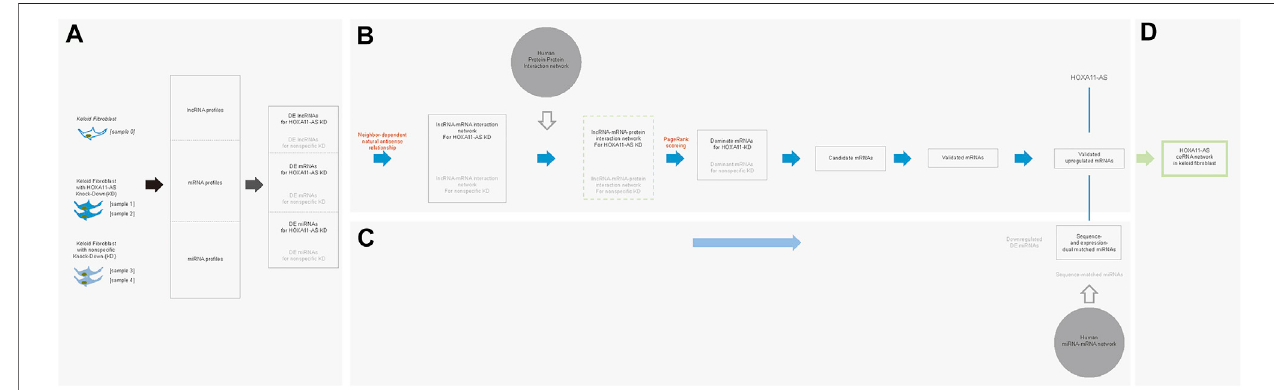
FIGURE 6 | Stepwise bioinformatic analysis of the HOXA11-AS-interactive molecular network in keloid fi broblasts. Five keloid fi broblast samples were sequenced and compared to create three differentially expressed (DE) pro fi les of lncRNAs, mRNAs, and miRNAs betweenHOXA11-AS-knockdown and normal samples as well as between nonspeci fi c control knockdown and normal samples. (A) . Based on DE lncRNA and mRNA pro fi les, an interactive network was initially constructed based natural/intronic antisense neighbor-dependent relationship. Based on the network, a lncRNA-mRNA-protein network was extended mediated by the human protein – protein interaction network. Within the integrated network, screened DE mRNAs were ranked by PageRank score to identify dominant functional mRNAs. CandidatemRNAswere in vitro validatedby qPCRand westernblotting.All overlapping molecules between thestudy andnonspeci fi ccontrolgroups wereremoved for each step (B) . Validated mRNAs were considered target genes and screened for competing endogenous mRNAs based on DE miRNAs. Simultaneously, these competing endogenous miRNAs underwent sequence-based validation. (C) . By the stepwise bioinformatic screening, an integrated molecule network of HOXA11- AS – three miRNAs – NIPAL3 interactions was shown in keloid fi broblast (D)